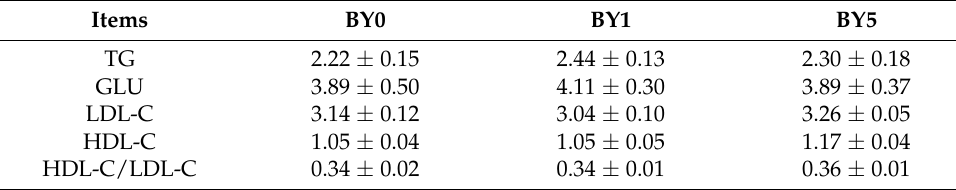
Table 2. Serum parameters of Trachinotus ovatus fed experimental diets for 42 days.